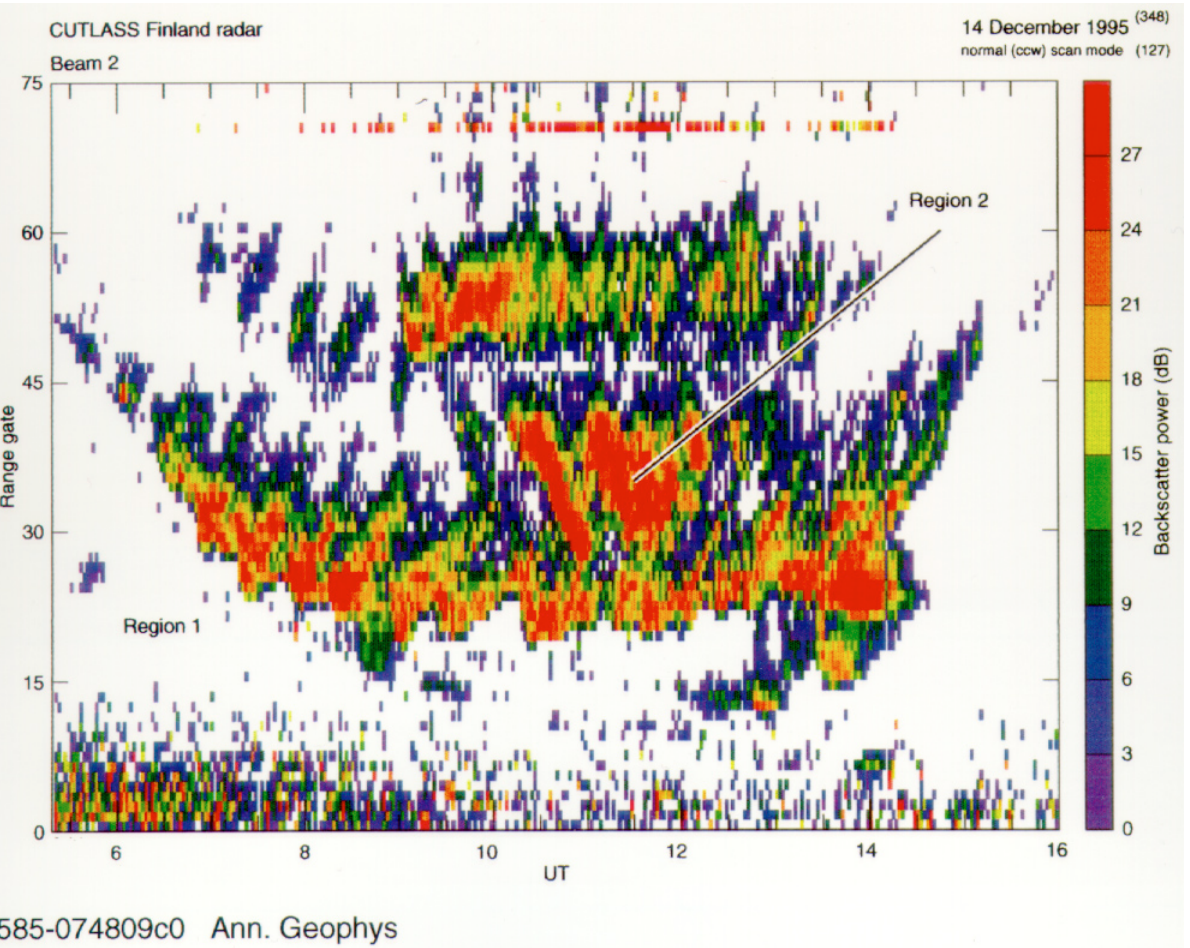
Fig. 9. Backscatter power RTI plot for beam 2 of the Finland radar, 14 December 1995. Evidence of gravity waves is seen in the regions of ground backscatter from behind ( region (cid:49) ) and in front of ( region (cid:50) ) of the